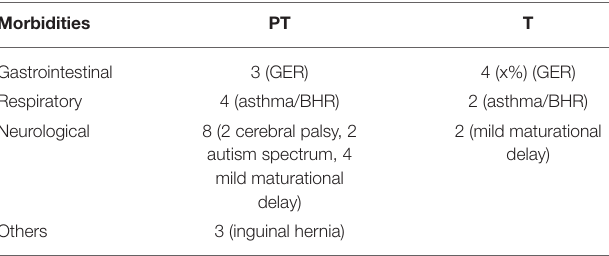
TABLE 2 | Long term morbidities of PT and T children included in the